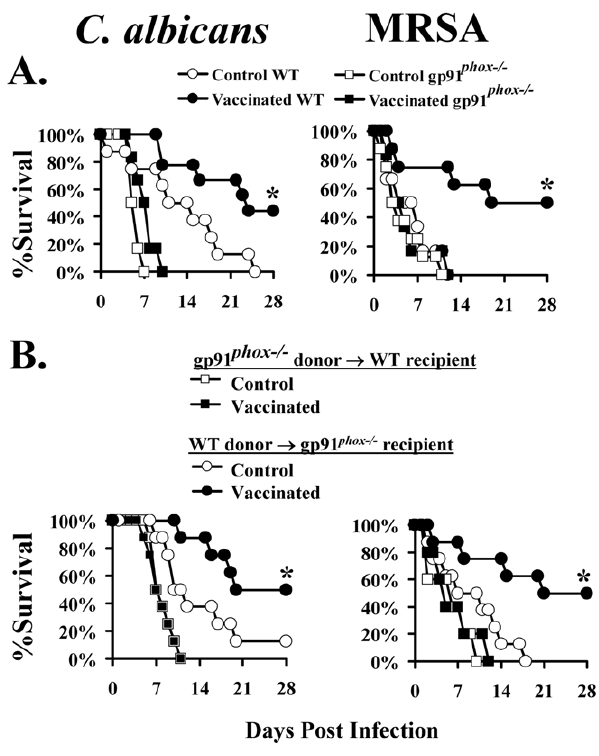
Figure 3. Phagocyte superoxide production is required for vaccine protection. N=8 mice per group. Wild type C57BL/6 mice were infected with 1.5 6 10 5 C. albicans SC5314 or 2 6 10 7 S. aureus LAC; gp91 phox 2 / 2 mice on a C57BL/6 background were infected with 1.5 6 10 3 C. albicans or 10 7 S. aureus . A) Mice were vaccinated and infected as above. *p , 0.05 for wild type vaccinated vs. control by